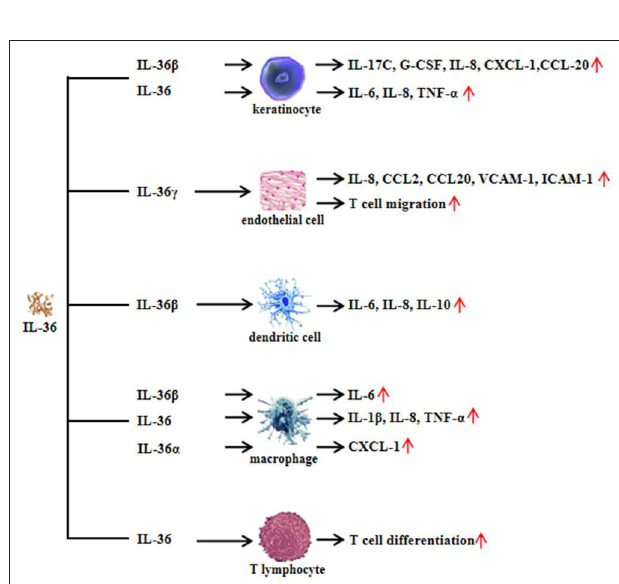
FIGURE 2 | Functional role of interleukin (IL)-36 in non-immune cells and immune cells. Non-immune cells include keratinocytes and endothelial cells. Immune cells include dendritic cells, macrophages, and T